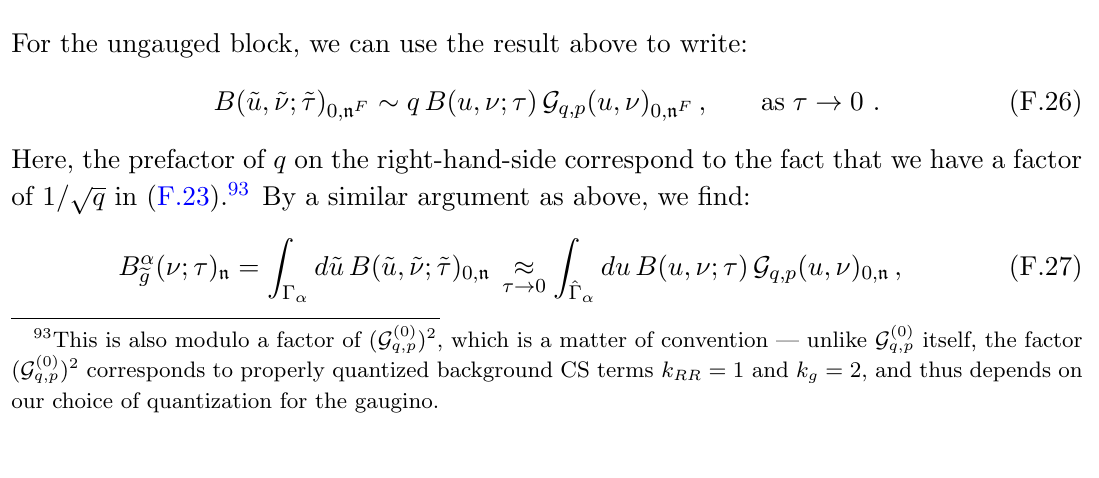
Figure 4 . In the limit (cid:28) ! 0, the dominant contributions to the integral over (cid:0) (cid:11) come from the regions around ^ u and their images. These can be reassembled into a series of q shifted copies of contours passing through the critical points u = q ~ u = ^ u; ^ u + 1 ; : : : ; ^ u + q (cid:0)